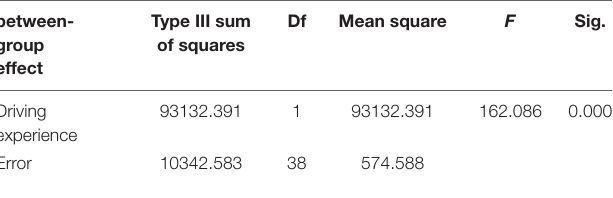
TABLE 14 | The test results of driving experience factor’s main effect. between-